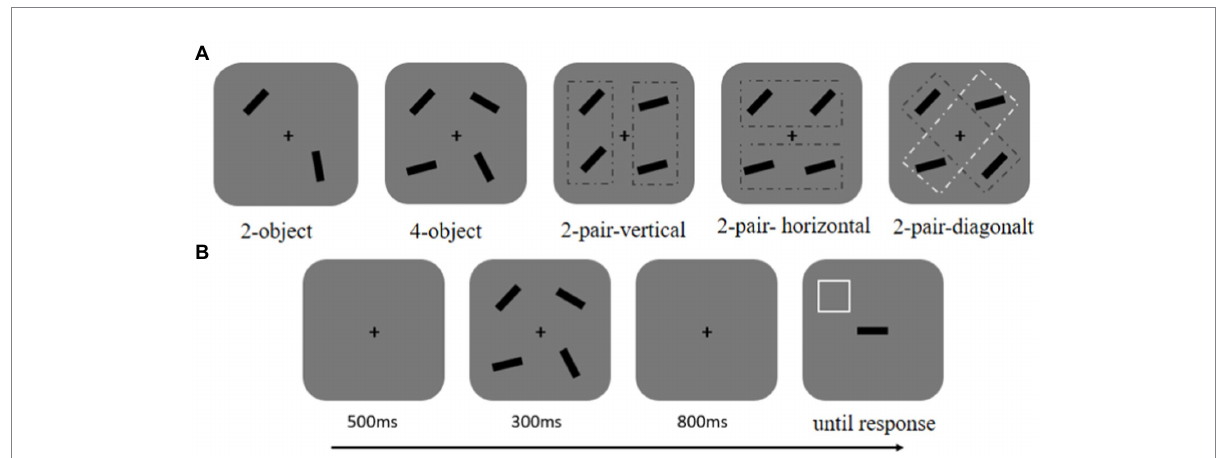
FIGURE 3 (A) Spatial configuration of memory items in Experiment 2. The memory arrays consisted of two unidentical objects (2-object), four unidentical objects (4-object), two pairs of identical objects arranged vertically (2-pair-vertical), two pairs of identical objects arranged horizontally (2-pair- horizontal), and two pairs of identical objects arranged diagonally (2-pair-diagonal). (B) The schematic of a